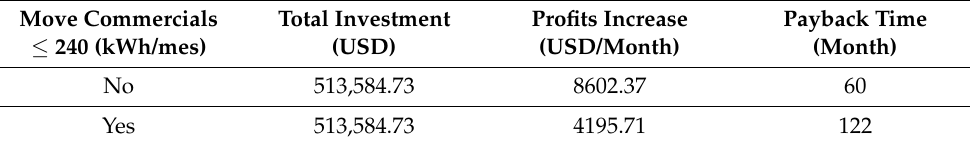
Table 11. Cost and investment recovery for